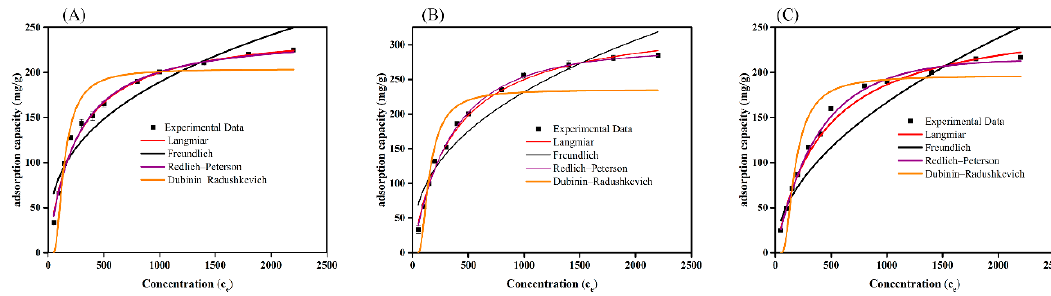
Figure 6. Adsorption isotherm model of ( A ) DR5B, ( B ) DB71, and ( C ) RB5 on SMWC. Table 1. Comparison of the maximum adsorption capacities of some anionic dyes on various adsorbents.